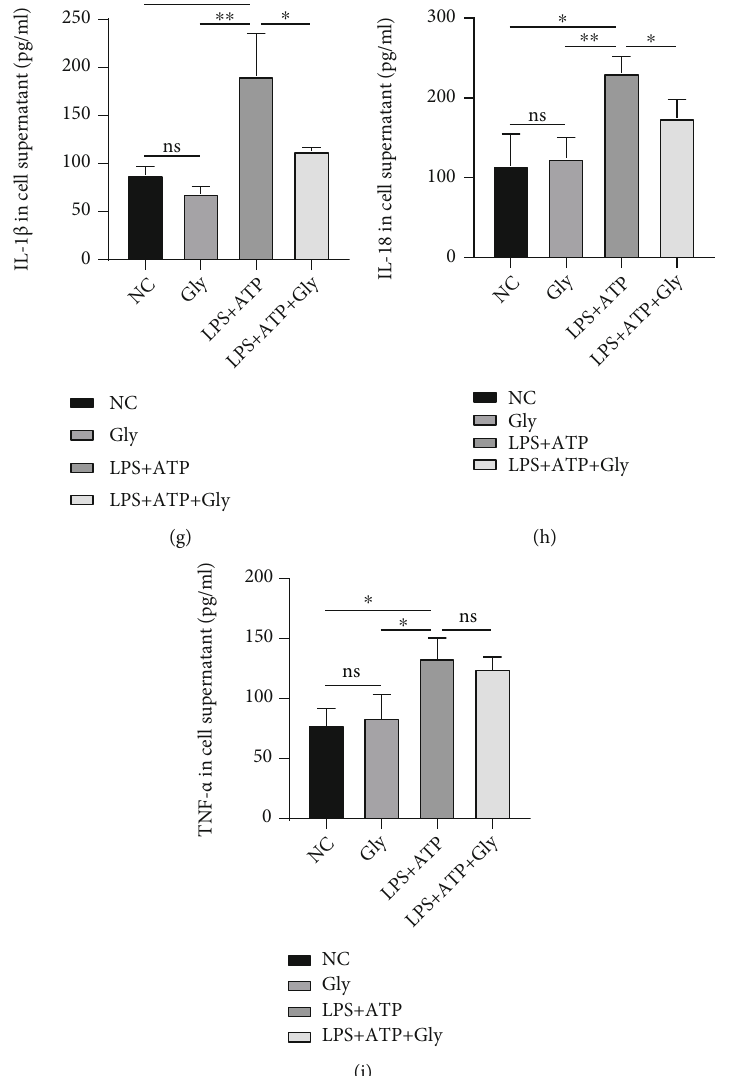
Figure 4: A protective role of glibenclamide in vitro in fl ammatory model. (a) CCK-8 assay was used to determine glibenclamide cytotoxicity ( n = 3 ). (b) Relative NLRP3 mRNA expression in PMs was measured by real-time PCR ( n = 3 ). (c, d) Representative images of Western blot of NLRP3 and Caspase-1/p20 in PMs and quantitative analysis ( n = 3 ). (e) Representative immuno fl uorescence staining of NLRP3 in PMs. (f) Calculated percentage of NLRP3-positive nuclei ( n = 3 ). (g – i) The level of IL-1 β , IL-18, and TNF- α in cell supernatant was measured by ELISA ( n = 3 ). Data are representative of three independent experiments (mean and SD). Scale bars, 20 μ m. ns: not signi fi cant. ∗ P < 0 : 05 , ∗∗ P < 0 : 01 , ∗∗∗ P < 0 : 001 , and ∗∗∗∗ P < 0 : 0001 (unpaired Student ’ s t